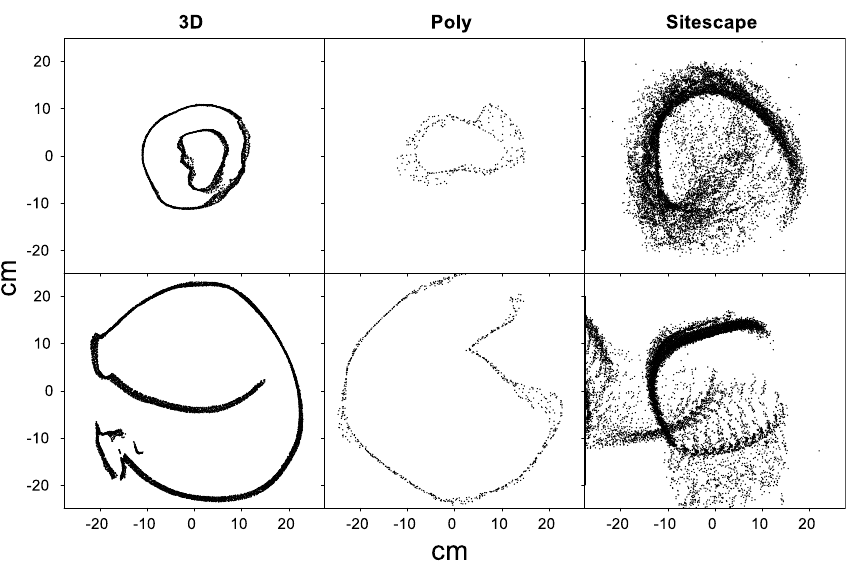
Figure 14. Cross-sections examples of misalignments with the iPad.